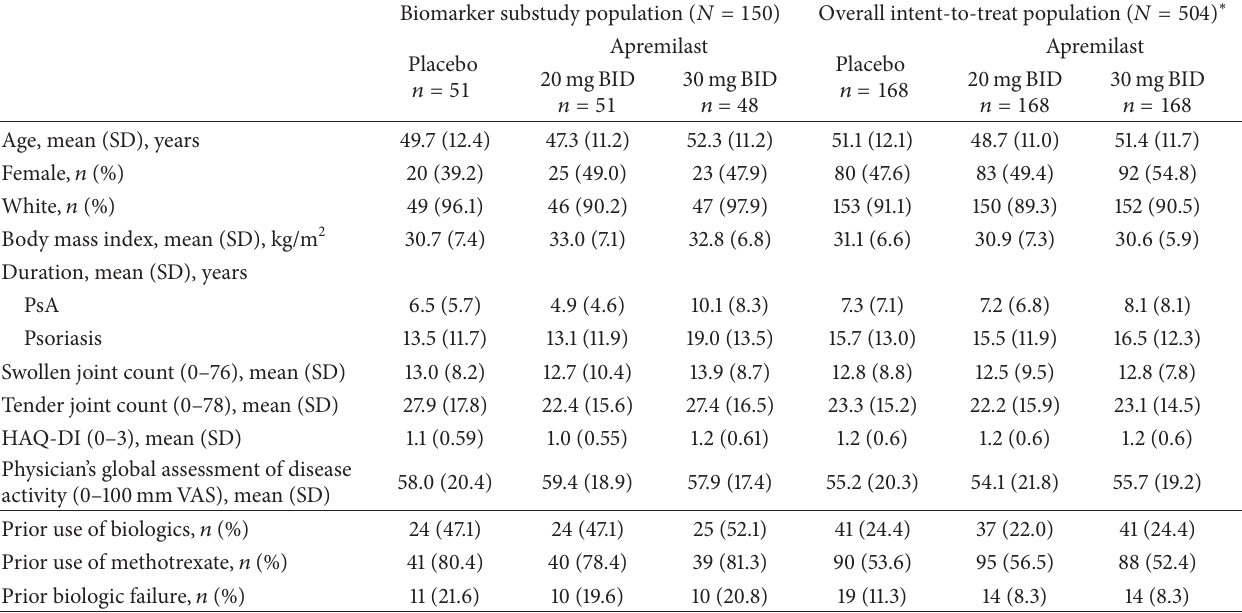
Table1:Baselinedemographicandclinicalcharacteristicsofbiomarkersubstudypatients( 𝑁 = 150 )andtheoverallintent-to-treatpopulation ( 𝑁 = 504 )